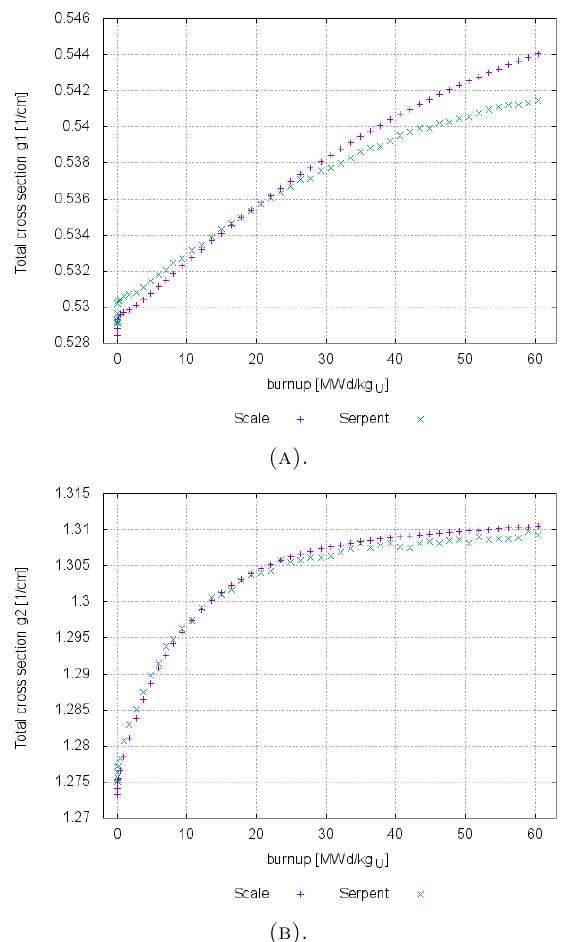
Figure 3. Total cross-section dependency on burnup for fast group (a) and for thermal group (b).